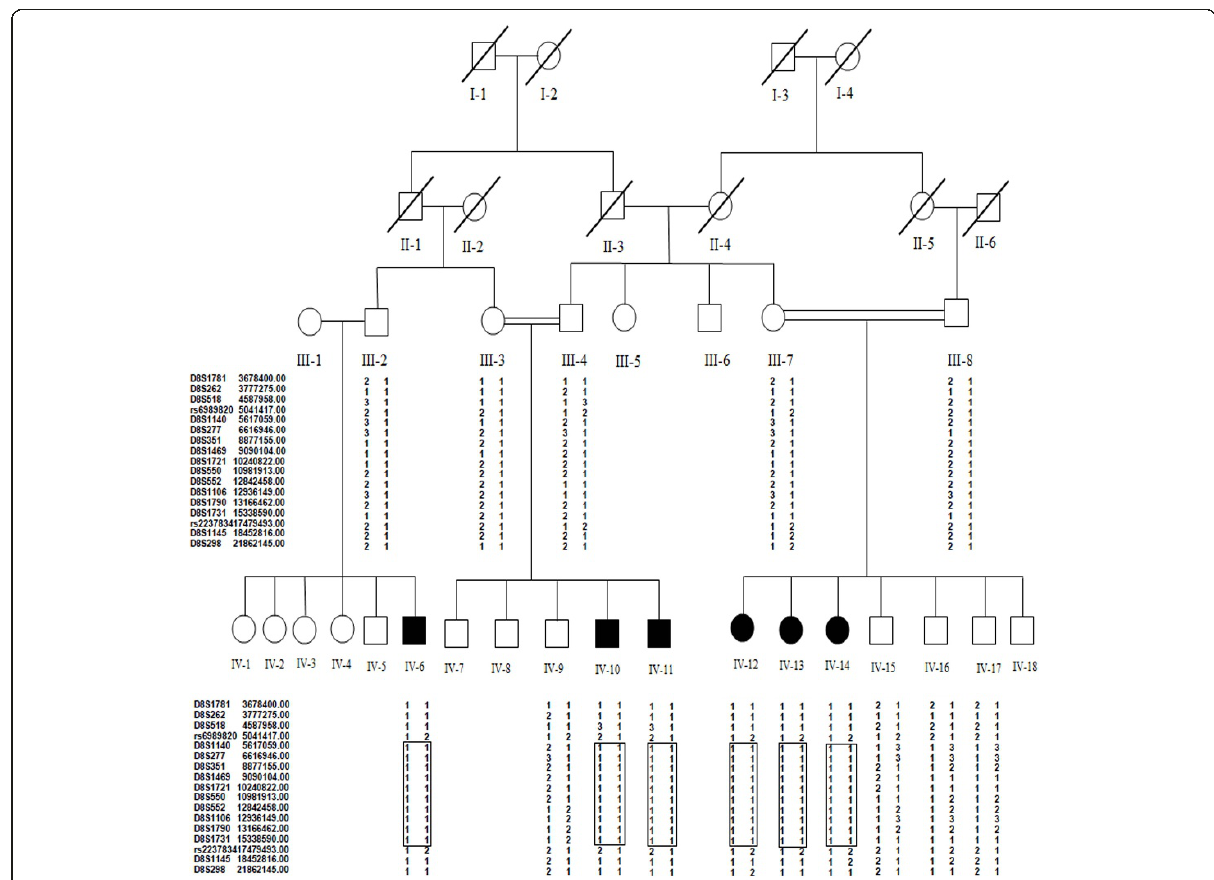
Figure 1 Pedigree of a Pakistani family segregating AR-NSID . Square represent male and circles female while black symbols represents affected individuals and clear symbols unaffected individuals. Autozygosity mapping was done for individuals IV-11, IV-12, IV-13 and IV-14. All affected individuals share a homozygous haplotype in the chromosome 8p23.1 region, which is shown in boxes. Markers with physical map distances are shown on the left side.